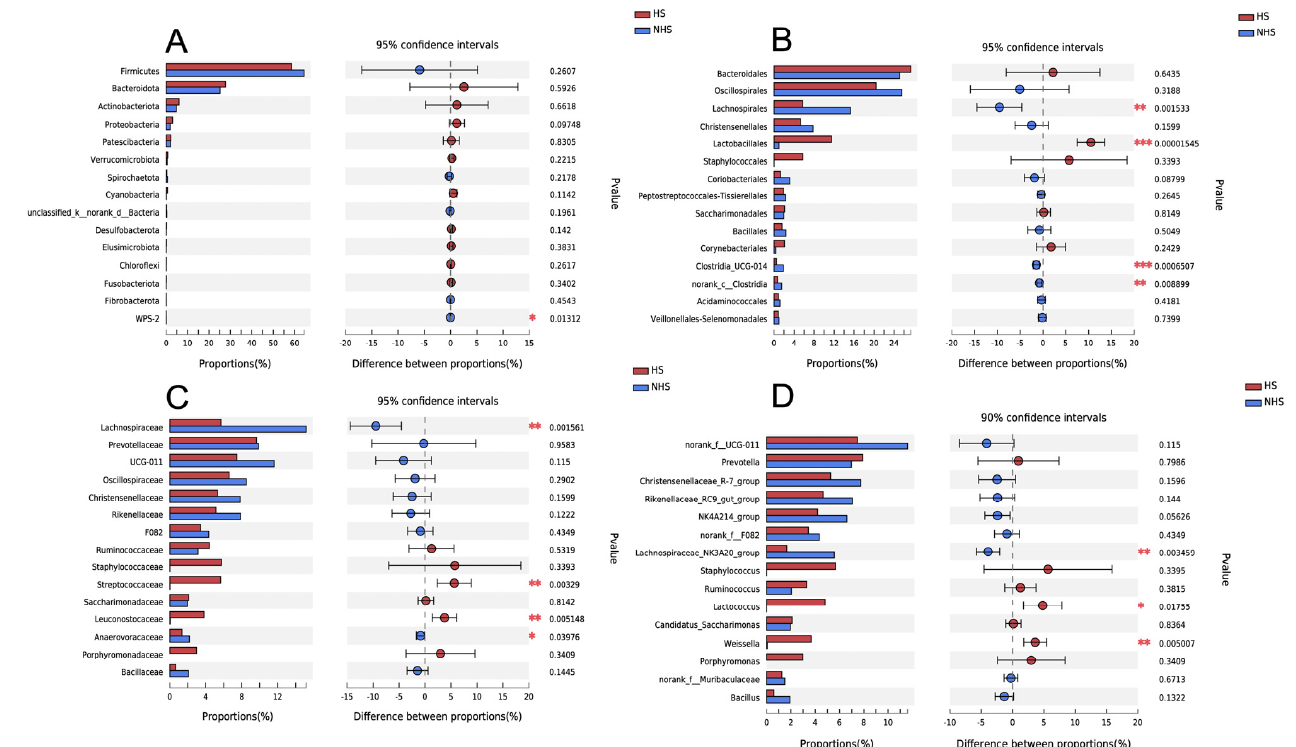
Figure 2. Rumen bacteria affected by heat stress at different taxonomical levels. ( A ) phylum ( B ) order level ( C ) family level ( D ) genus level. * represents p < 0.05, ** represents p < 0.01, *** represents p < 0.001. NHS, non-heat stress condition; HS, heat stress condition.